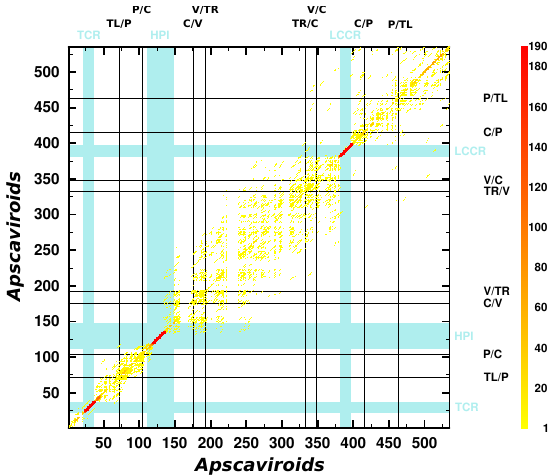
Figure 3. Overlay of N UC A LN matches on a MAFFT X-INS- I alignment of all members of Apscaviroid . Parameters for N UC A LN were k = 4, g = 4, and w = 25. In the alignments, consensus sequences of ACFSVd (1 sequence), ADFVd (28 sequences), AFCVd (75), AGVd (157), ASSVd (118), CBLVd (52), CDVd (130), CVd-V (19), CVd-VI (18), CVd-VII (4), DVd (17), GLVd (3), GYSVd-1 (109), GYSVd-2 (70), GYSVd-3 (23), LVd (1), PBCVd (61), PlVd-I (39), PVd-2 (2), and PVd (3) were used (Table S1). Domain borders of ASSVd [13] are marked by black lines. Blue bars and labels mark TCR (Figure S10b), HPI (Figure S23), and LCCR (Figure